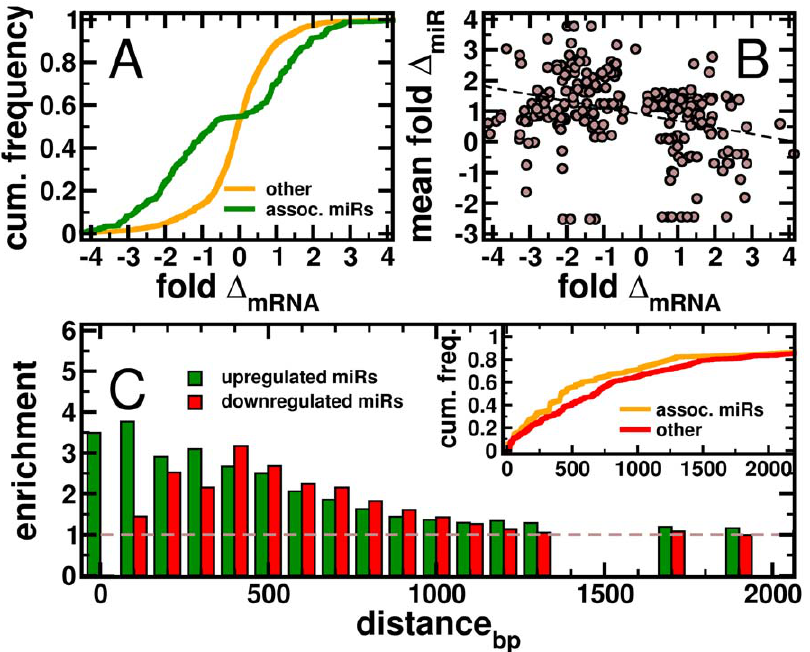
Figure 2. Characteristics of significantly associated miRs. ( A ) A sigmoidal curve described the fold change of all mRNAs that appeared in signaling pathways and were not bound by significantly associated miRs. Focusing on mRNAs that appeared to be regulated by significantly associated miRs, the corresponding distribution significantly shifted toward higher and lower fold changes. ( B ) For each mRNA, we calculated the mean fold change of all miRs that were significantly associated with a given mRNA. Specifically, we found that the expression fold change significantly decreased with increasing expression of miRs (Pearson’s r= 2 0.30, P , 10 2 6 ). In the inset of ( C ), we utilized the binding positions of miRs on the 3 9 UTR of a given mRNA and calculated the cumulative frequency of significantly associated miRs. In comparison to other miRs we observed an overrepresentation of associated miRs that bind near the start of the 3 9 UTR. Focusing on associated miRs, we determined the enrichment of over- expressed miRs (fold change . 1) in sets of miRs that bind within a certain distance from the start of the 3 9 UTR. We clearly observe that over-expressed miRs tend to increasingly bind nearby the 3 9 UTR start. Considering under-expressed miRs (FC ,2 1), we find that the enrichment distribution peaks around 500 bp form the start of the 3 9